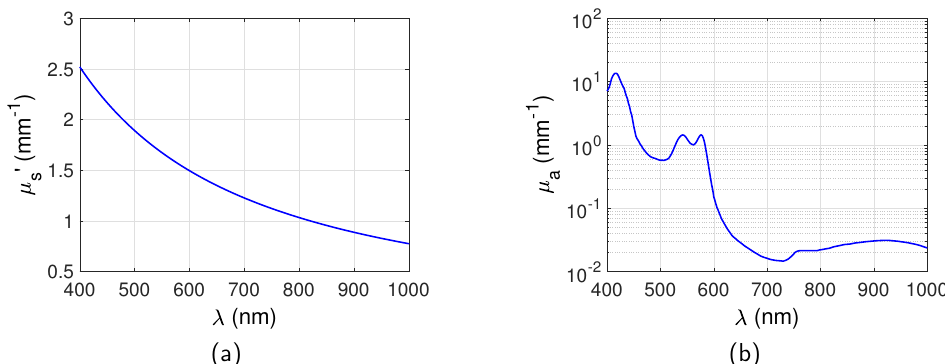
Figure 2. Spectra of ( a ) reduced scattering coefficient and ( b ) absorption coefficient, obtained based on Equations (2) and (3). a = 1.89mm − 1 , b = 1.286, B = 0.0511, S = 0.8 [22]. µ a , oxy and µ a , deoxy are obtained from the authors of